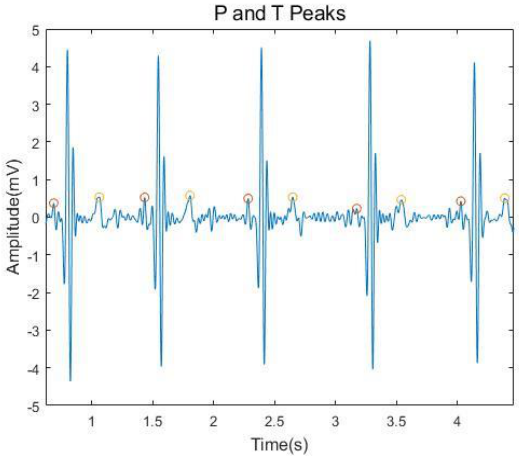
Figure 7. Detected P and T peaks of an ECG signal.